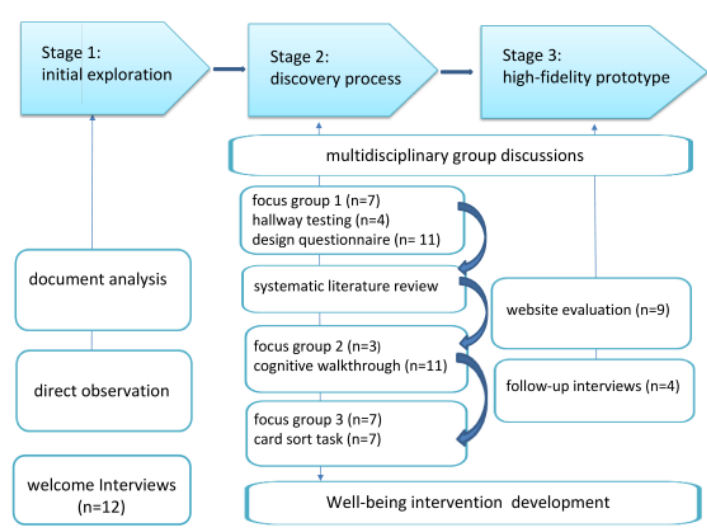
Figure 1. Study diagram.